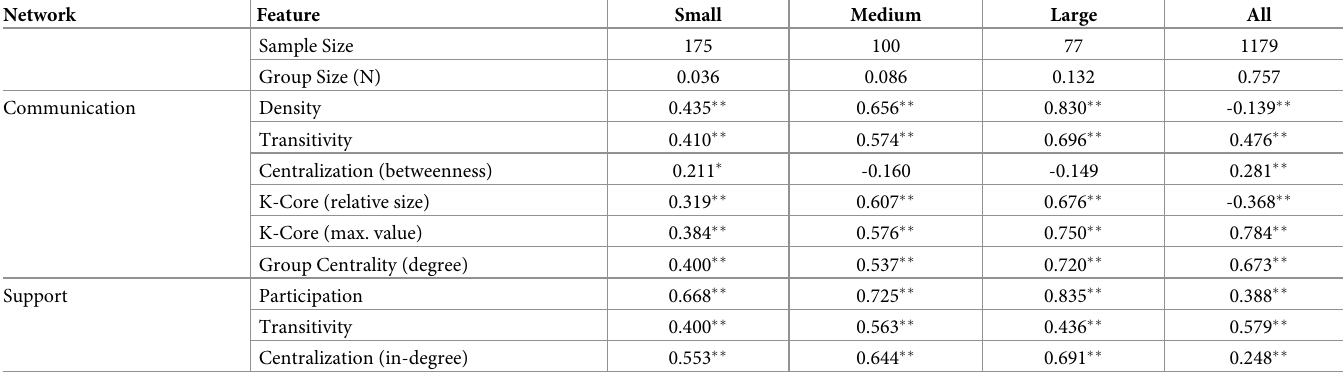
Table 3. Correlation of each network measure with team performance for the groups of small- (15–25 members), mid- (35–45 members), and large-size teams (55– 65 members) as well as all teams (10–143 members) ( � : p � .01, �� : p � .001). Network